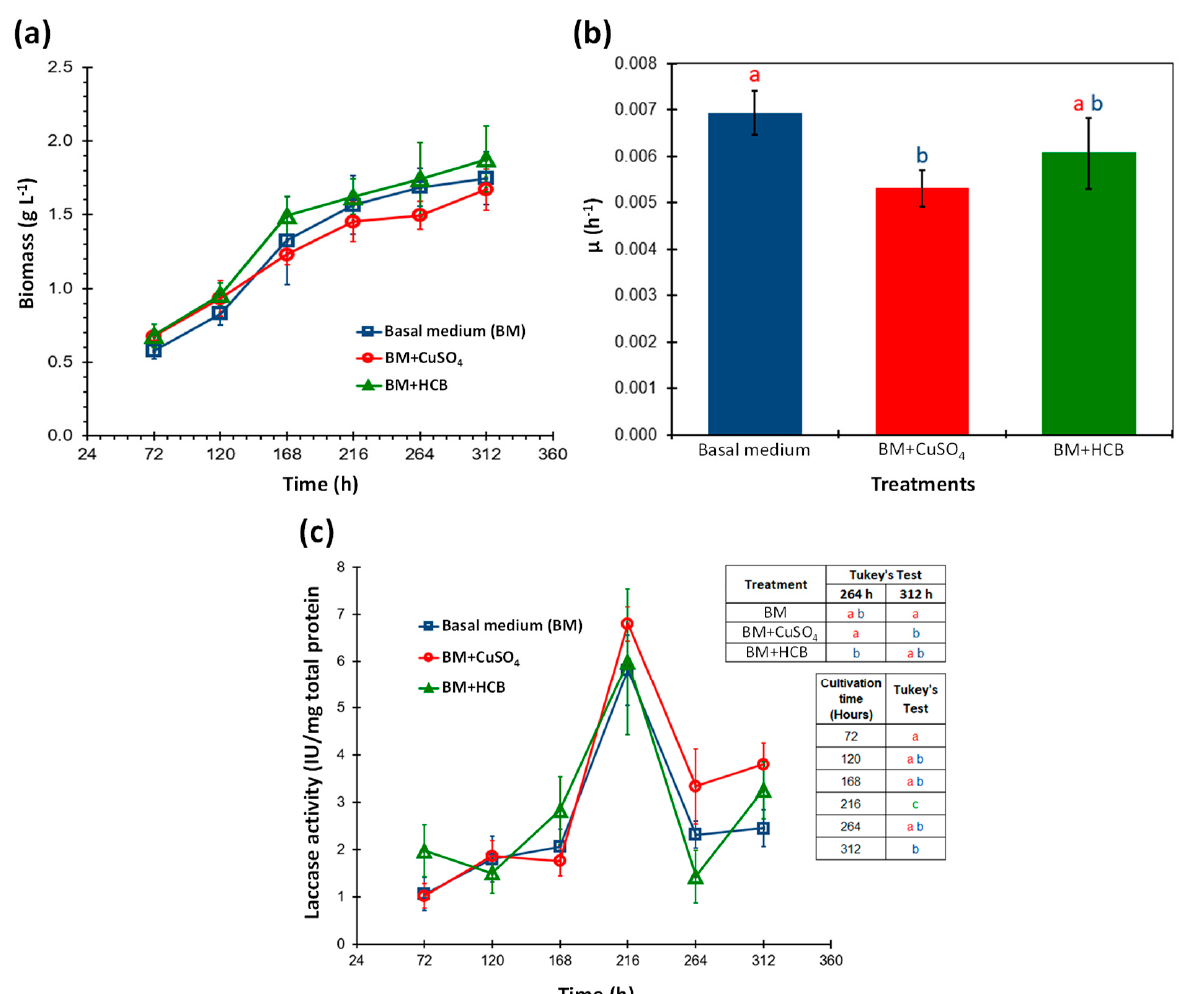
Figure 1. Growth and detection of extracellular laccase activity produced by Agrocybe pediades at different culture hours. ( a ) Biomass production. ( b ) Specific growth rate constant ( μ ) of the fungus. ( c ) Measurement of laccase activity. Basal medium (BM) ( □ ); BM+CuSO 4 ( ο ) , and BM+HCB ( Δ ). The value shown for each time corresponds to the mean + standard deviation (SD). Different letters (a,b) indicate the statistical differences using Tukey’s test ( p ≤ 0.05).